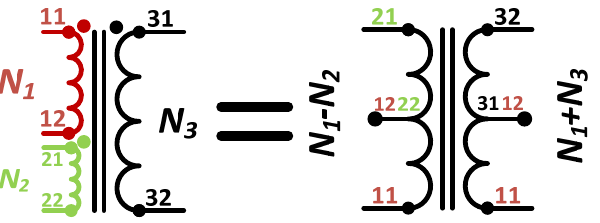
Figure 4. The schematic diagram of the three-winding coupled inductor.